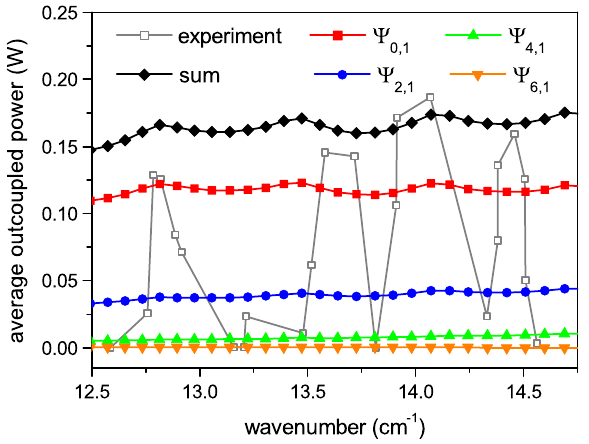
FIG. 10. FLARE average out-coupled power obtained with 15 MeV electrons at the fixed cavity length of 7492 mm while scanning the undulator gap (see Fig. 1) is presented in gray. The numerical results obtained with the same parameters are shown with solid symbols. In the simulation the macropulse duration was considered to be 2 μ